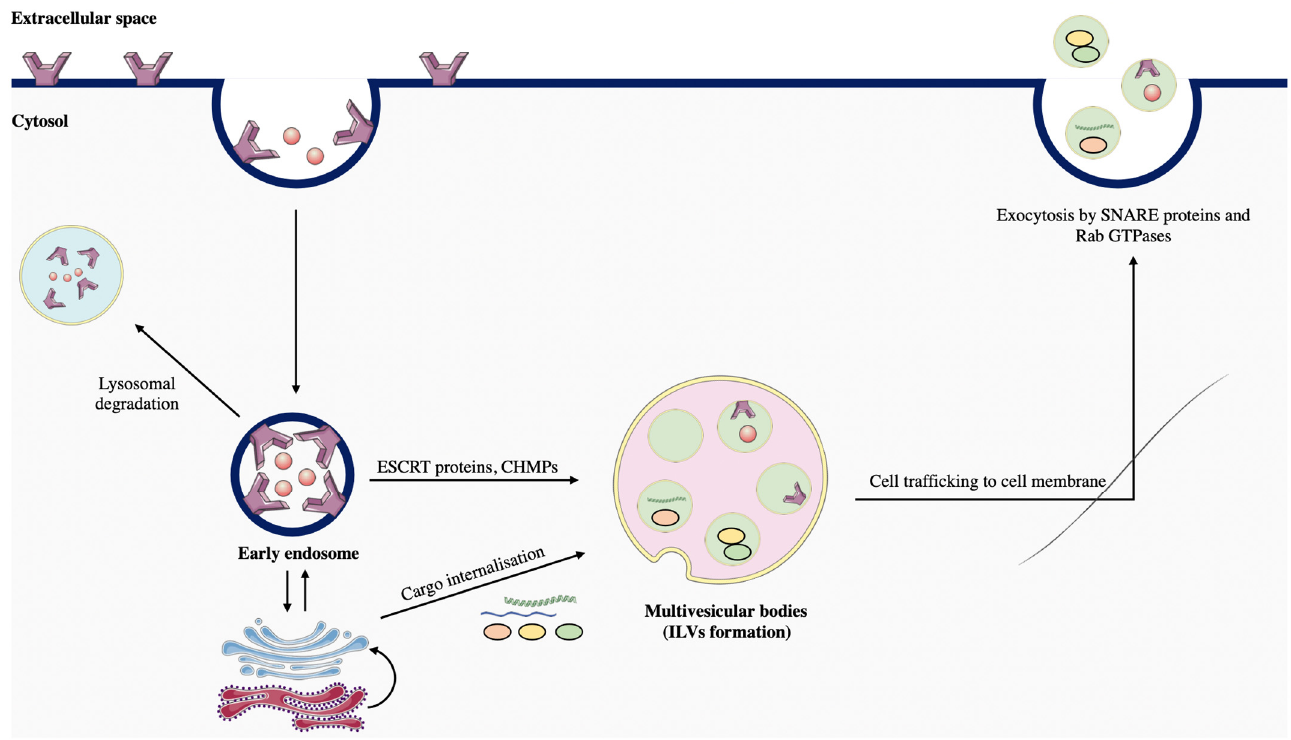
Figure 4. Main steps involved in exosomal biogenesis. Exosome formation is initiated by the endocytic pathway. Endocytosis of cell membrane components and lipids leads to the formation of early endosomes in the cytosol. Endosome sorting by ESCRT and CHMP proteins leads to the formation of multivesicular bodies composed of intraluminal vesicles (ILVs). Cell trafficking processes transfer late endosomes to the cell membrane, where the exocytic pathway expels exosomes in the extracellular space. (The Figure was partly generated using Servier Medical Art, provided by Servier, li-